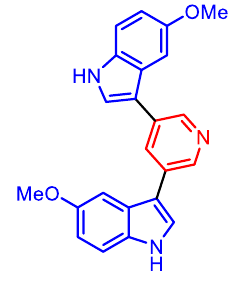
Figure 23. O , O (cid:48) -dimethyl scalaridine A ( 28ad ) [49]. Figure 23. O , O‘ -dimethyl scalaridine A ( 28ad ) [49].